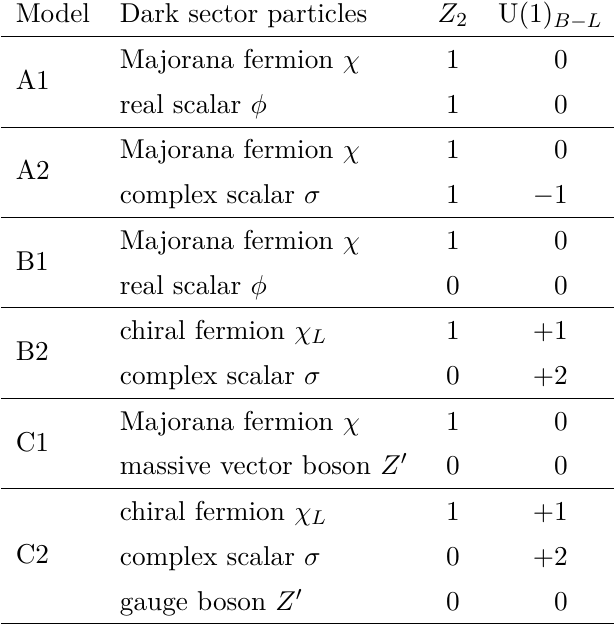
charge. In 2 , not charged R